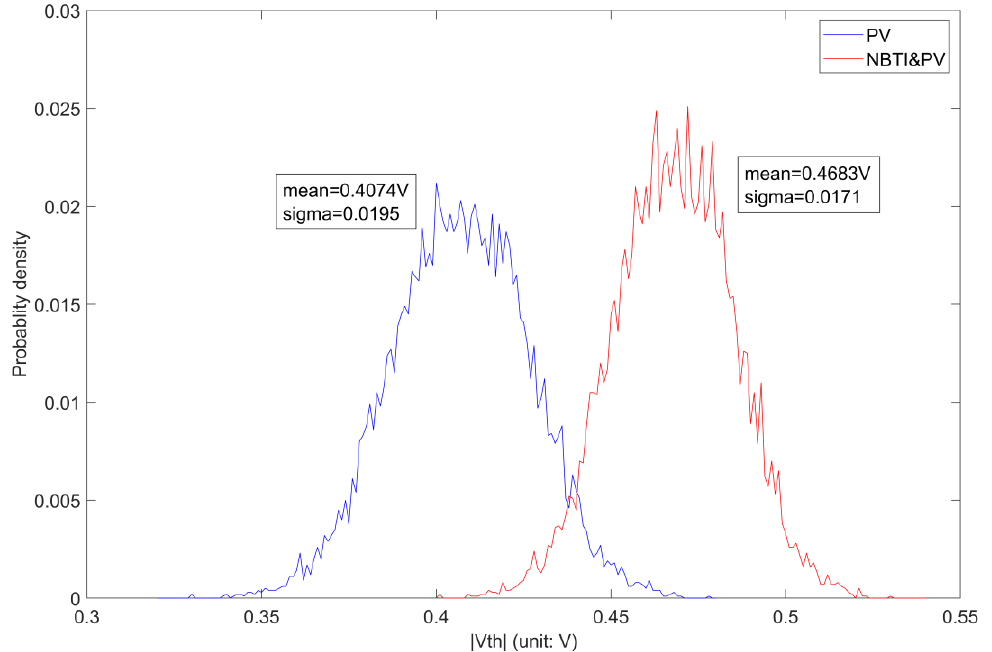
Figure 1. The probability density of V th considering PV and NBTI&PV.